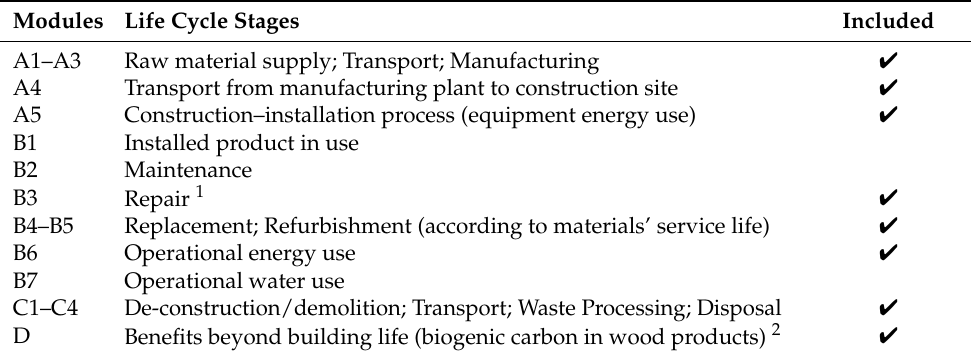
Table 1. Life cycle stages available in the LCA tools used in current